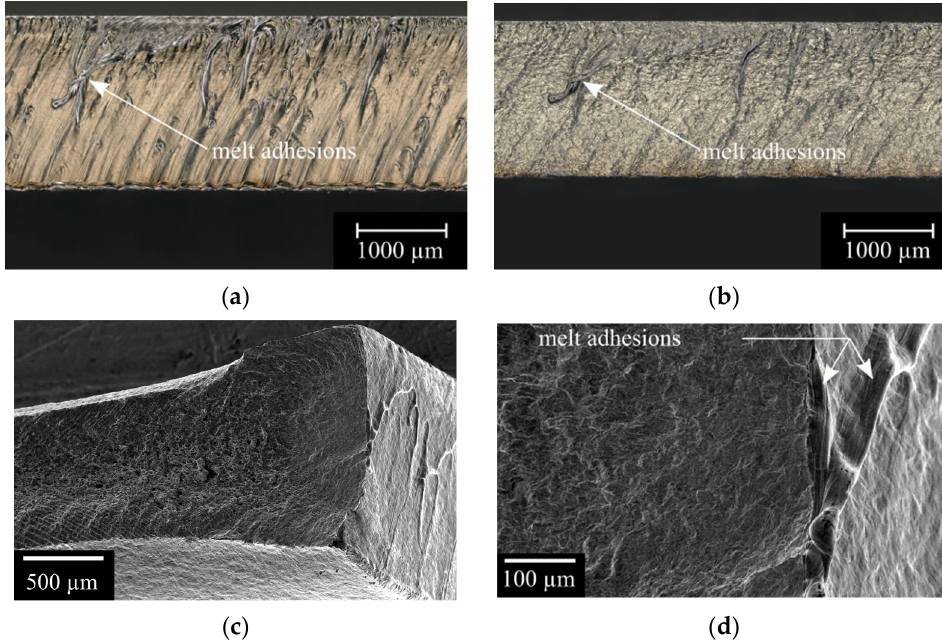
Figure 7. Crack initiation origin of a representative specimen with dross-free cut edge in the states ( a ) before pre-deformation and ( b ) after pre-deformation. ( c ) SEM image of the crack initiation region with melt adhesions. ( d ) Enlarged SEM image of the crack initiation site.